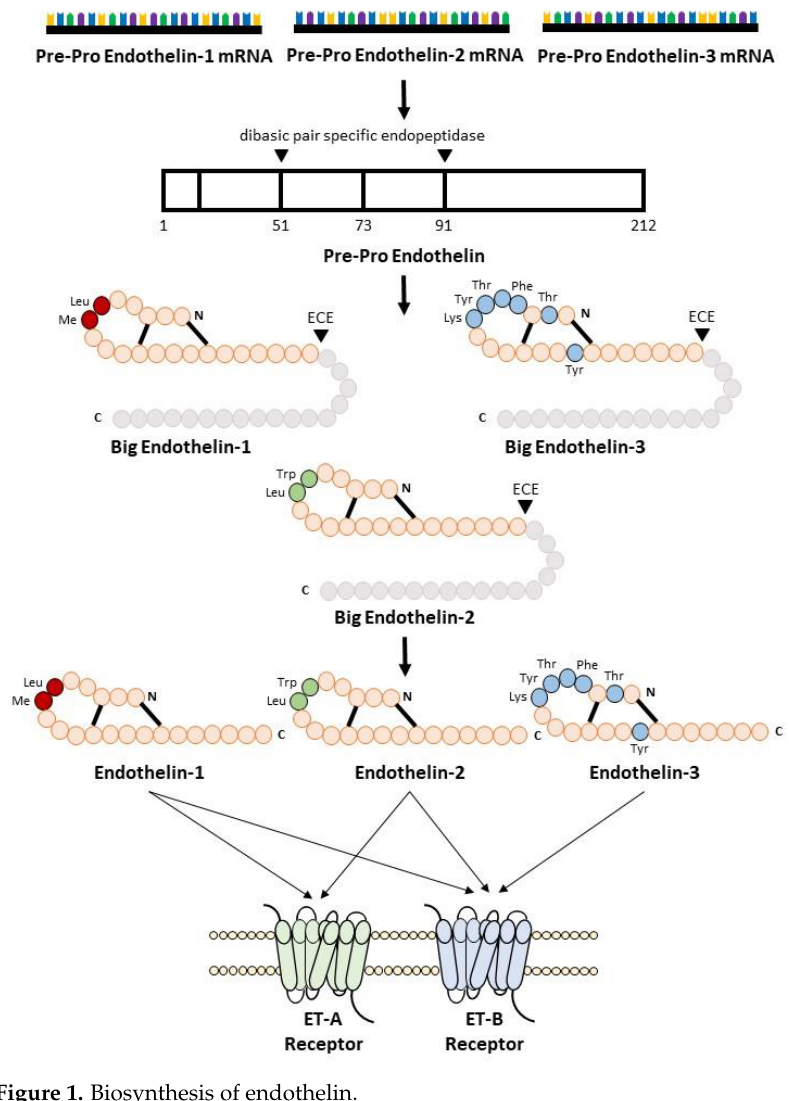
Figure 1. Biosynthesis of endothelin.